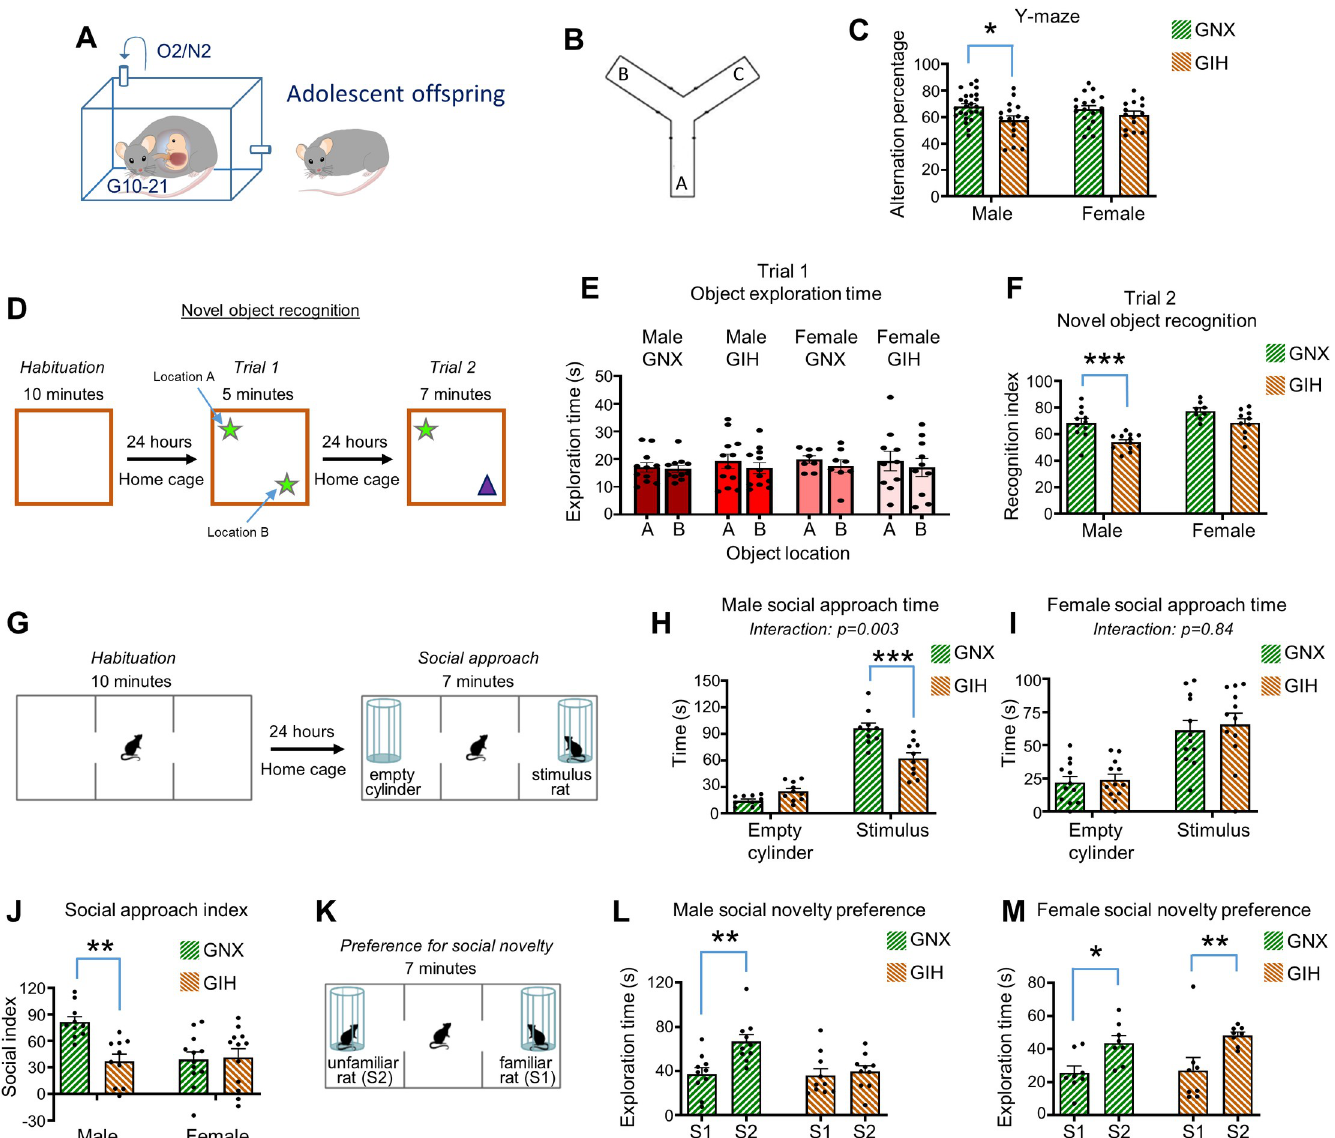
Fig 2. Male adolescent GIH offspring display cognitive and social phenotypes. (A) Schematic depicting GNX and GIH offspring age pertaining to all data in Fig 2 . (B) Y-maze schematic. (C) Mean Y-maze spontaneous alternation percentage. Male [Bonferroni post hoc (df,69) p = 0.0115], but not female (Bonferroni post hoc (df,69) p = 0.6126), GIH offspring show an alternation deficit relative to GNX offspring. n = 25 male GNX, 18 female GNX, 16 male GIH, 14 female GIH rats. (D) Schematic of the novel object recognition task. (E) Object exploration time during trial 1 of the object recognition test revealed no differences in time investigating either object location in GNX and GIH male or female offspring for all group comparisons [Bonferroni post hoc (df,37), male GNX p = 1.0; male GIH p = 0.6596; female GNX p = 1.0; female GIH p = 0.9064]. n = 11 male GNX, 8 female GNX, 12 male GIH, 10 female GIH rats. (F) Novel object recognition index during trial 2 revealed a deficit in male GIH offspring [Bonferroni post hoc (df,37) p = 0.0008] with no significant impairment in female GIH offspring [Bonferroni post hoc (df,37) p = 0.0782]. n = 11 male GNX, 8 female GNX, 12 male GIH, 10 female GIH rats. (G) Schematic of social approach task. (H) Time spent investigating each cylinder in the social approach task for male adolescents. GIH offspring spent less time investigating the stimulus rat cylinder than GNX offspring [Bonferroni post hoc (df,36) p < 0.0001]. n = 10 male GNX, 10 male GIH. (I) Time spent investigating each cylinder in the social approach task for female adolescents. No differences in time spent investigating the social cylinder was detected between GNX and GIH offspring [Bonferroni post hoc (df,44) p > 0.999]. n = 12 female GNX, 12 female GIH. (J) Social approach revealed a significant social index deficit in male GIH offspring [Bonferroni post hoc (df,40) p < 0.002] with no corresponding alteration in female GIH offspring (Bonferroni post hoc (df,40) p = 1.0). n = 10 male GNX, 12 female GNX, 10 male GIH, 12 female GIH rats. (K) Schematic of preference for social novelty task. (L) Social novelty preference in male GIH and GNX offspring. Whereas male GNX offspring exhibited a significant increase in the amount of time investigating the novel (S2) versus familiar rat (S1) [Bonferroni post hoc (df,18) p = 0.0076], male GIH rats did not show an increased preference for social novelty [Bonferroni post hoc (df,18) p = 1.0]. n = 10 GNX and 10 GIH rats. (M) Social novelty preference in female GIH and GNX offspring. Both GNX and GIH female offspring show a significant increase in time spent investigating the novel (S2) versus familiar (S1) rat [Bonferroni post hoc (df,14) GNX p = 0.0242; GIH p = 0.0093]. n = 8 GNX and 8 GIH rats. All bar graphs are the mean + SEM. The data underlying this figure can be found in S1 Raw Data. GIH, gestational intermittent hypoxia; GNX, gestational normoxia; S1, stimulus rat 1; S2, stimulus rat 2.